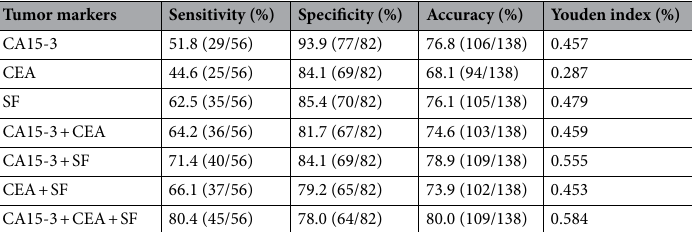
Table 4. Sensitivity, specificity, accuracy, and Youden index of single and combined detections of serum CA15-3, CEA and SF levels in canine mammary gland tumors.